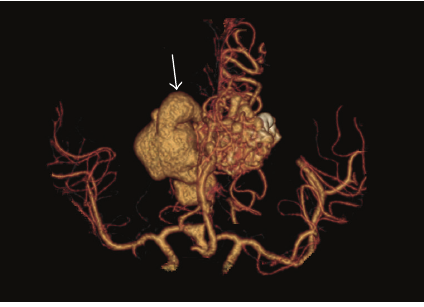
Figure9:AxialcontrastenhancedCTA(MIP)surfaceshadedimage of the brain demonstrating a serpiginous intraventricular enhancing structure (arrow). The AVM is supplied by branches of the anterior cerebral artery and drains via superior sagittal sinus.